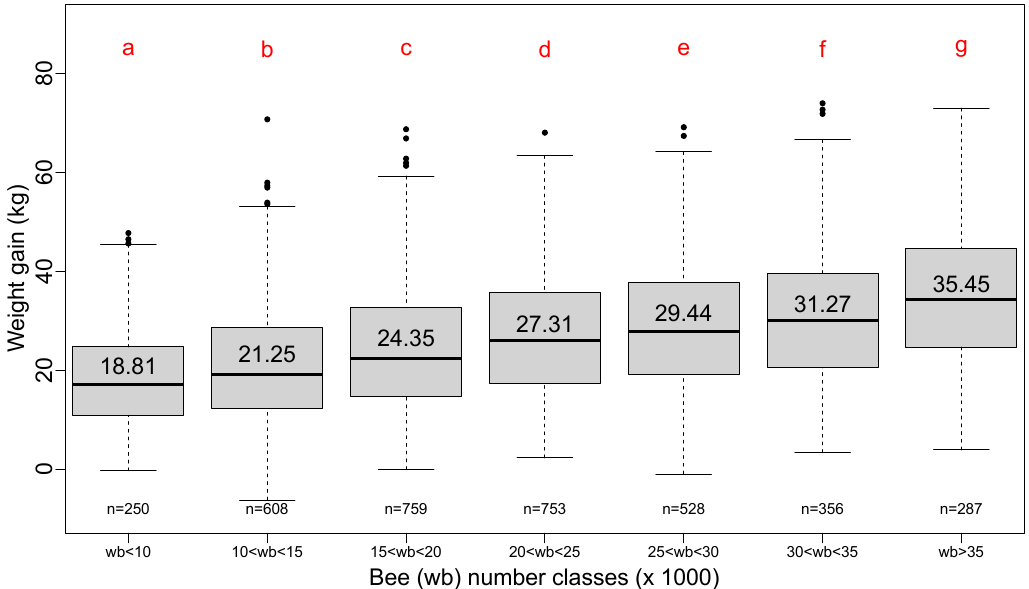
Figure 5. Boxplot series of seven classes of honey bee numbers. Step of increase: 5000 bees. Red letters result from a pairwise Student test ( p -value < 0.05). Number in each box plot is the average total weight gain for that class. Number “n=” below each box plot is the number of hives surveyed for that class. Annual variations are shown in Appendix A: Figure A2.